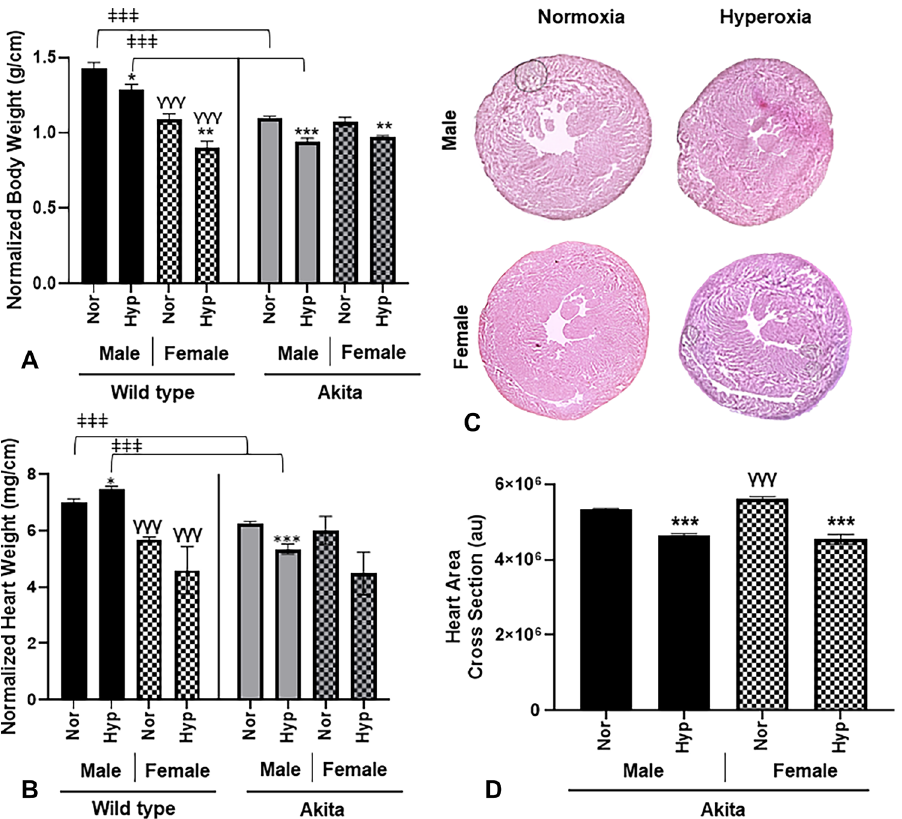
Figure 1. Akita male mice at both normoxia and hyperoxia experience a significant decrease in body and heart weight. ( A ) Body weight normalized to tibia length (g/cm) for all experimental groups, ( B ) Heart weight normalized to tibia length for all experimental groups (mg/cm), ( C ) H&E histological cross sections of Akita male and female mice under normoxia and hyperoxia, ( D ) Heart area cross sections (au), ( E ) WGA stained cardiac myocytes stained from Akita male and female mice. ( F – I ) Cardiac myocyte area of Akita male and female mice under normoxia or hyperoxia shown as follows: ( F ) LV cardiomyocte area, ( G ) RV cardiomyocte area, ( H ) Septum cardiomyocte area, ( I ) Pooled cardiomyocte area. Error bars represent ± SEM. *p < 0.05, **p < 0.005 ***p < 0.0005. *compares effects of hyperoxia and normoxia of same gender and strain; Y compares male and female mice of the same strain and treatment; ‡compares WT and Akita of same gender and